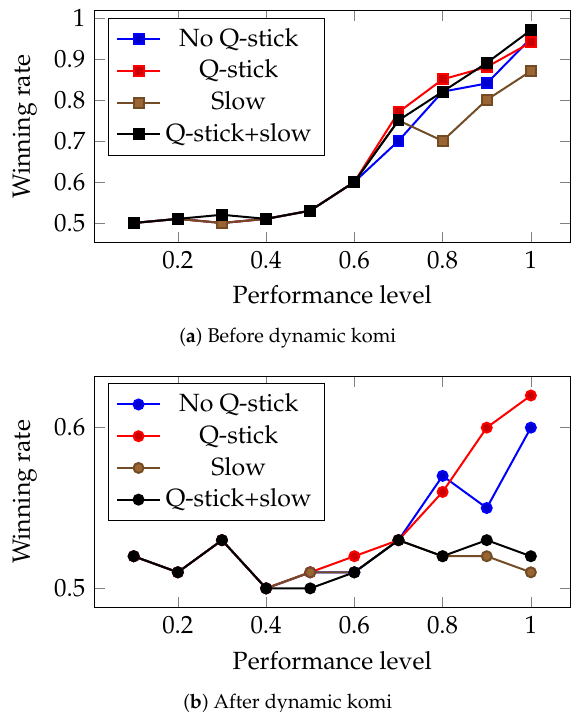
Figure 5. Illustration of winning rate obtained using different strategies before and after dynamic komi was